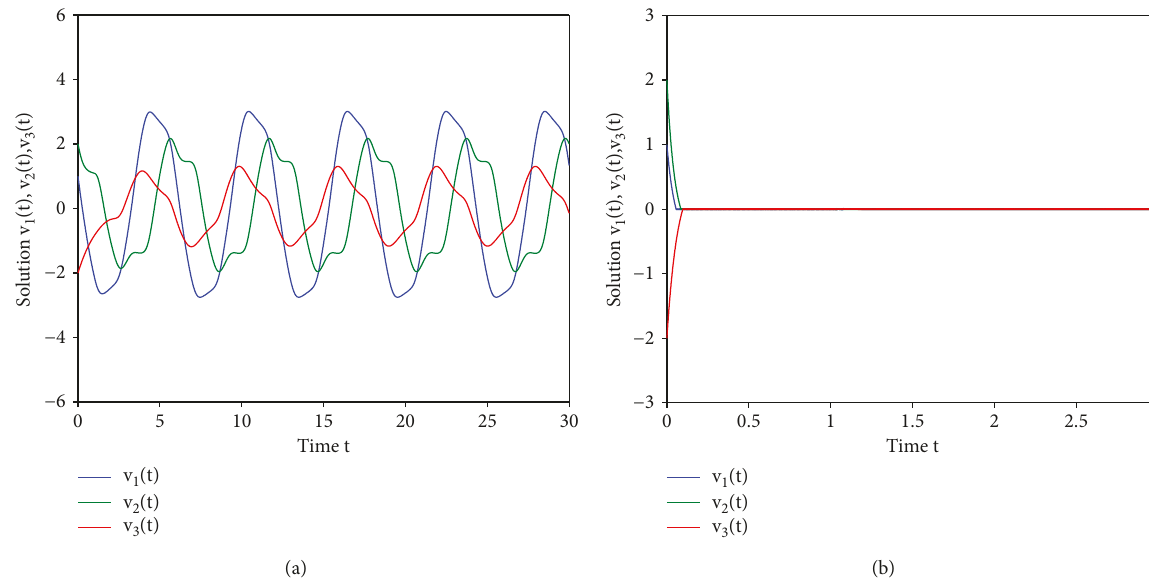
Figure 2: (a) The trajectories of state variables v t , v t , and v t in (71) with the discontinuous state feedback controller v 1 2 3